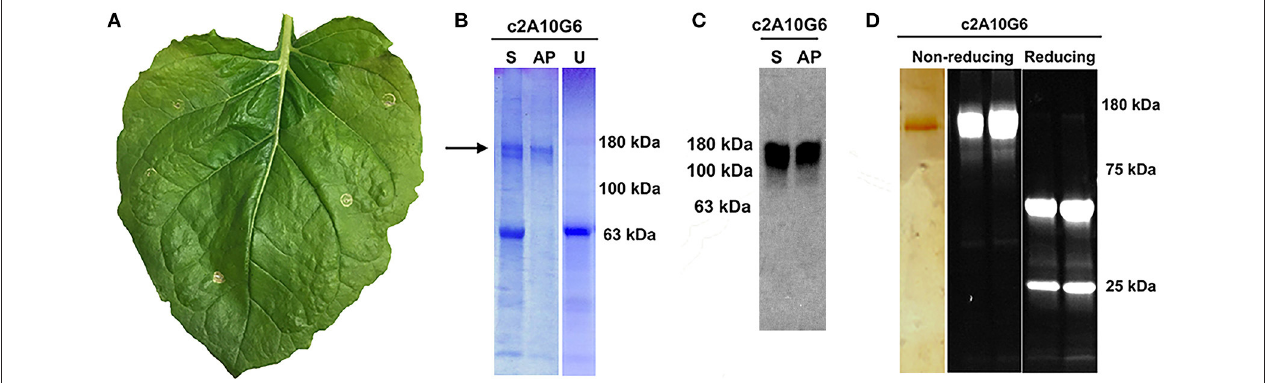
FIGURE 7 | Characterization of c2A10G6. (A) A N. benthamina leaf at 4 DPI was examined for signs of chlorosis or necrosis. Faint chlorosis was visible, but there was no visible necrosis. (B) To test whether the clarified leaf extracts of the antibody constructs were stable upon acid-precipitation, 1N phosphoric acid was added to a final acid volume of 4% of the total soluble extract. Following a 6-min incubation, the samples were neutralized with 1M Tris base. For comparison, a sample of the leaf extract pre-acid precipitation was also included along with a control uninfiltrated leaf extract that was not treated with acid. All three samples were mixed with non-reducing sample buffer and loaded on a 4–15% polyacrylamide gel for analysis by Coomassie-staining. (C) The same samples described in part A were run on a 4–15% polyacrylamide gel for analysis by Western blot. The Western blot was detected with HRP-conjugated goat anti-human IgG (kappa only). (D) After protein G affinity purification, samples of the purified antibody were run on SDS-PAGE gels under non-reducing or reducing conditions as noted. The left panel shows the results following a silver stain. Only the c2A10G6 band is visible. The two panels on the right show the results of the purified antibody run under non-reducing and reducing conditions on a stain-free gel. S, soluble fraction pre-acid precipitation; AP, samples subjected to acid-precipitation; U, uninfiltrated clarified leaf extract; NR, non-reducing conditions; R, reducing conditions.